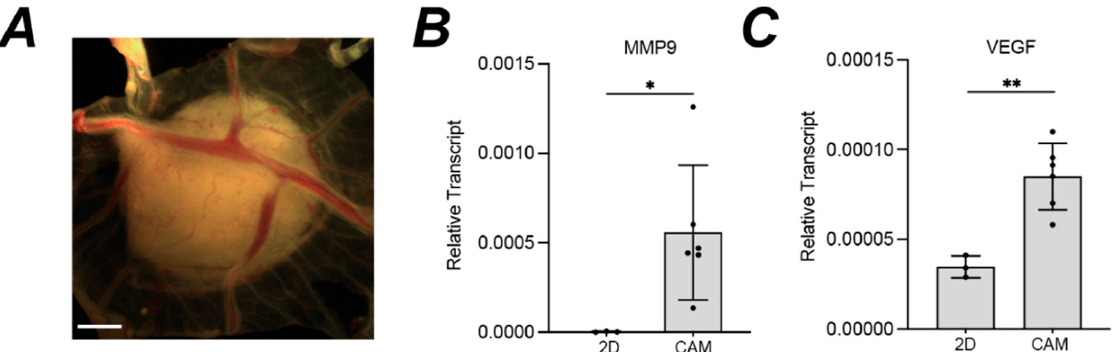
Figure 6. MPM tumour nodules increase transcription of invasive and angiogenic genes compared to 2D cultures. ( A ) Representative image of MSTO-211H tumour nodule used for RNA extraction, scale bar 1 mm; ( B , C ) qRT-PCR analysis comparing expression of MMP9 ( B ) and VEGF ( C ) transcript levels in MSTO-211H grown as 2D in vitro cultures ( n = 3) versus 3D CAM nodules ( n = 6). Mean expression shown relative to the mean of ACTB and GAPDH (2 ∆ Cq ), error bars SD, unpaired t -test, * p < 0.05, ** p < 0.01. Supporting data for housekeeping genes in Figure S5. All experiments were in ovo.